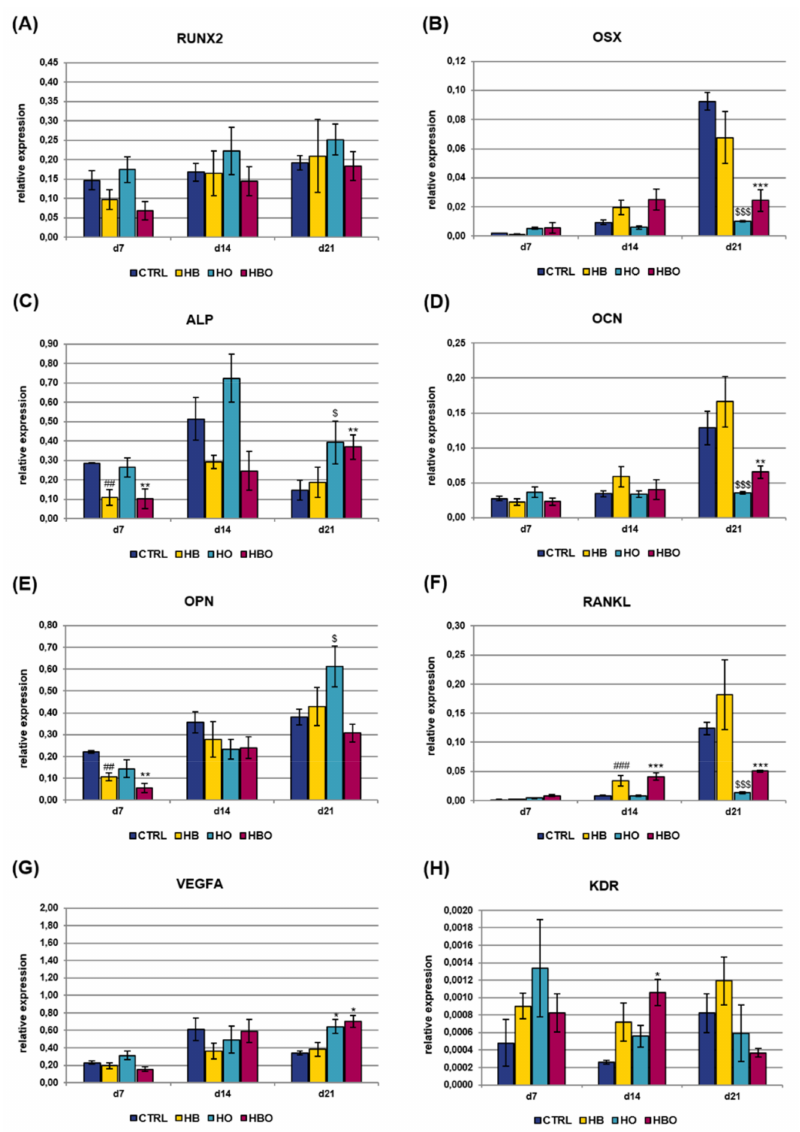
Figure 6. Gene expression profile of osteogenic and vasculogenic markers in hADSCs after HBO treatment. Expression of the osteoblast lineage genes ( A ) RUNX2; ( B ) OSX; ( C ) ALP; ( D ) OCN; ( E ) OPN; ( F ) RANKL; ( G ) VEGFA; and ( H ) KDR measured by real-time PCR. Data are expressed as mean ± SD of the target gene versus reference gene (transferrin receptor, TFRC) ratio and represented by 2deltaCt. *, $ p < 0.05, ##, ** p < 0.01, and ###, $$$, *** p < 0.001 mark significant changes in gene expression level compared to the control within the same measurement